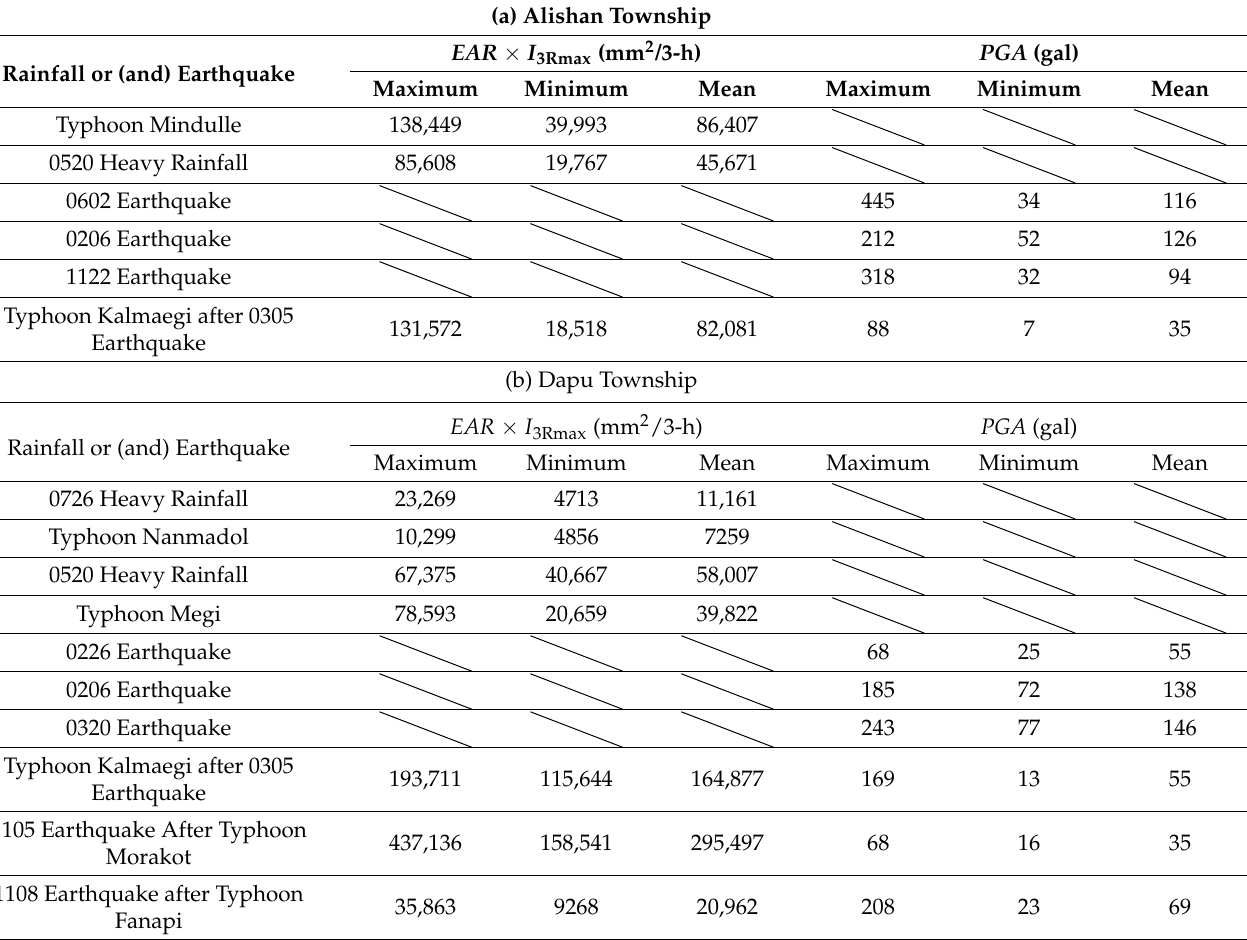
Figure 13. Landslide area ratio of medium–high-level landslides induced by rainfall and earthquakes in Dapu Township. Table 14. EAR × I 3Rmax and PGA after rainfall and earthquakes.